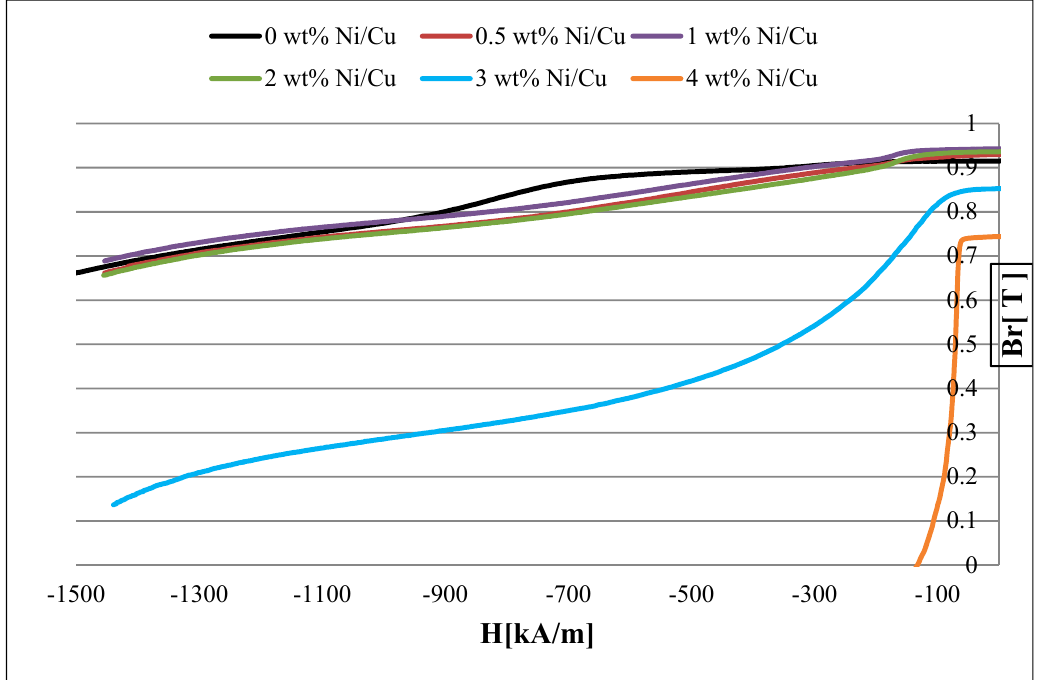
Figure 1. Demagnetization curves for the SmCo 5 magnets with 0–4 wt% Ni/Cu contents.